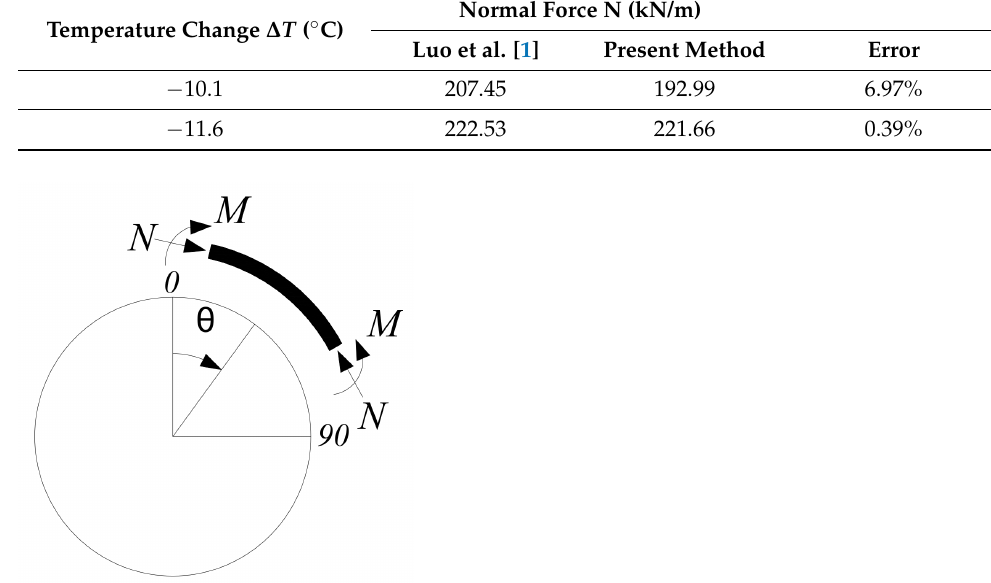
Figure 3. Positive direction of the lining forces. θ : the angle between the element axis and the vertical axis of tunnel cross-section.